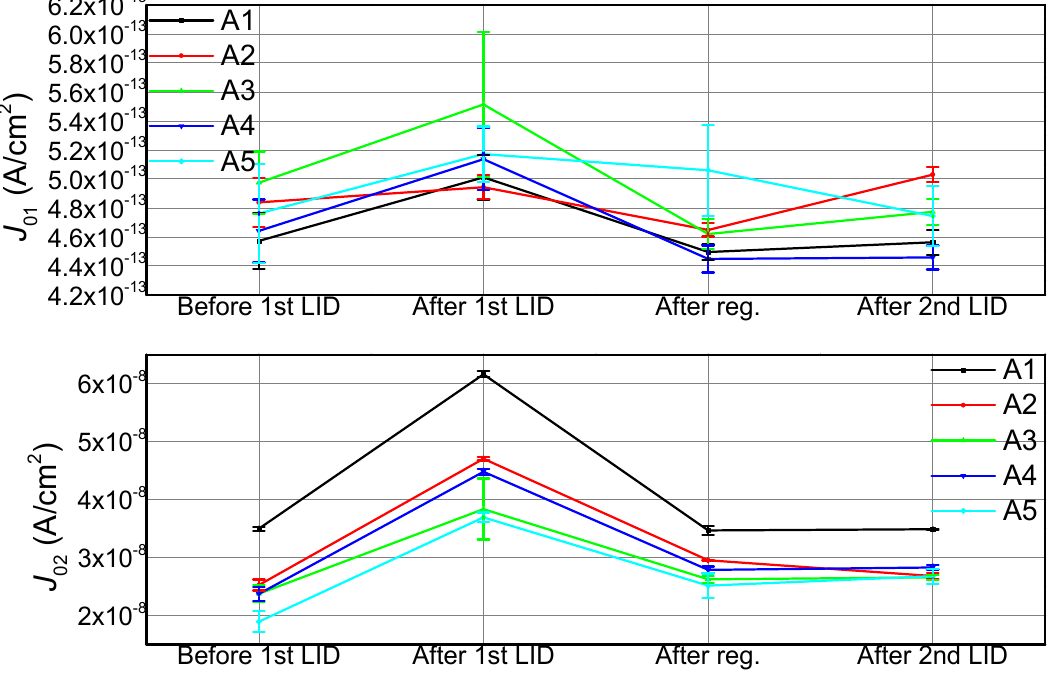
Figure 5. The variations of dark saturation current density ( J 01 , J 02 ) of the five groups of Al-BSF solar cells with the processing steps.